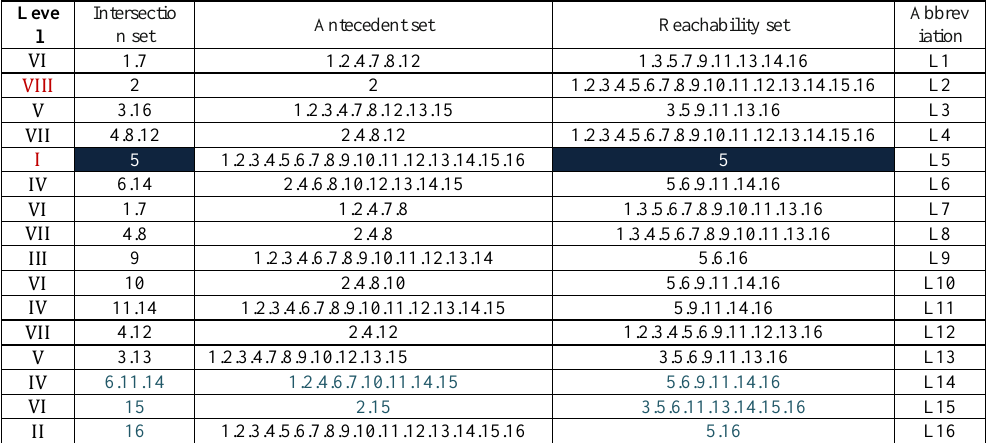
Table 11. The output and input set elements and commonalities of